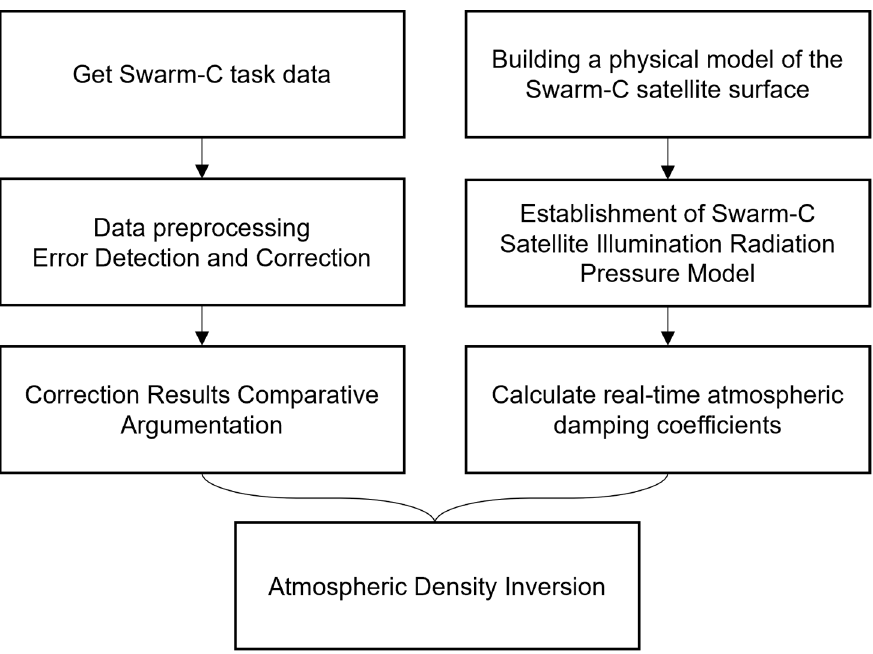
Figure 1. The main workflow of this study.